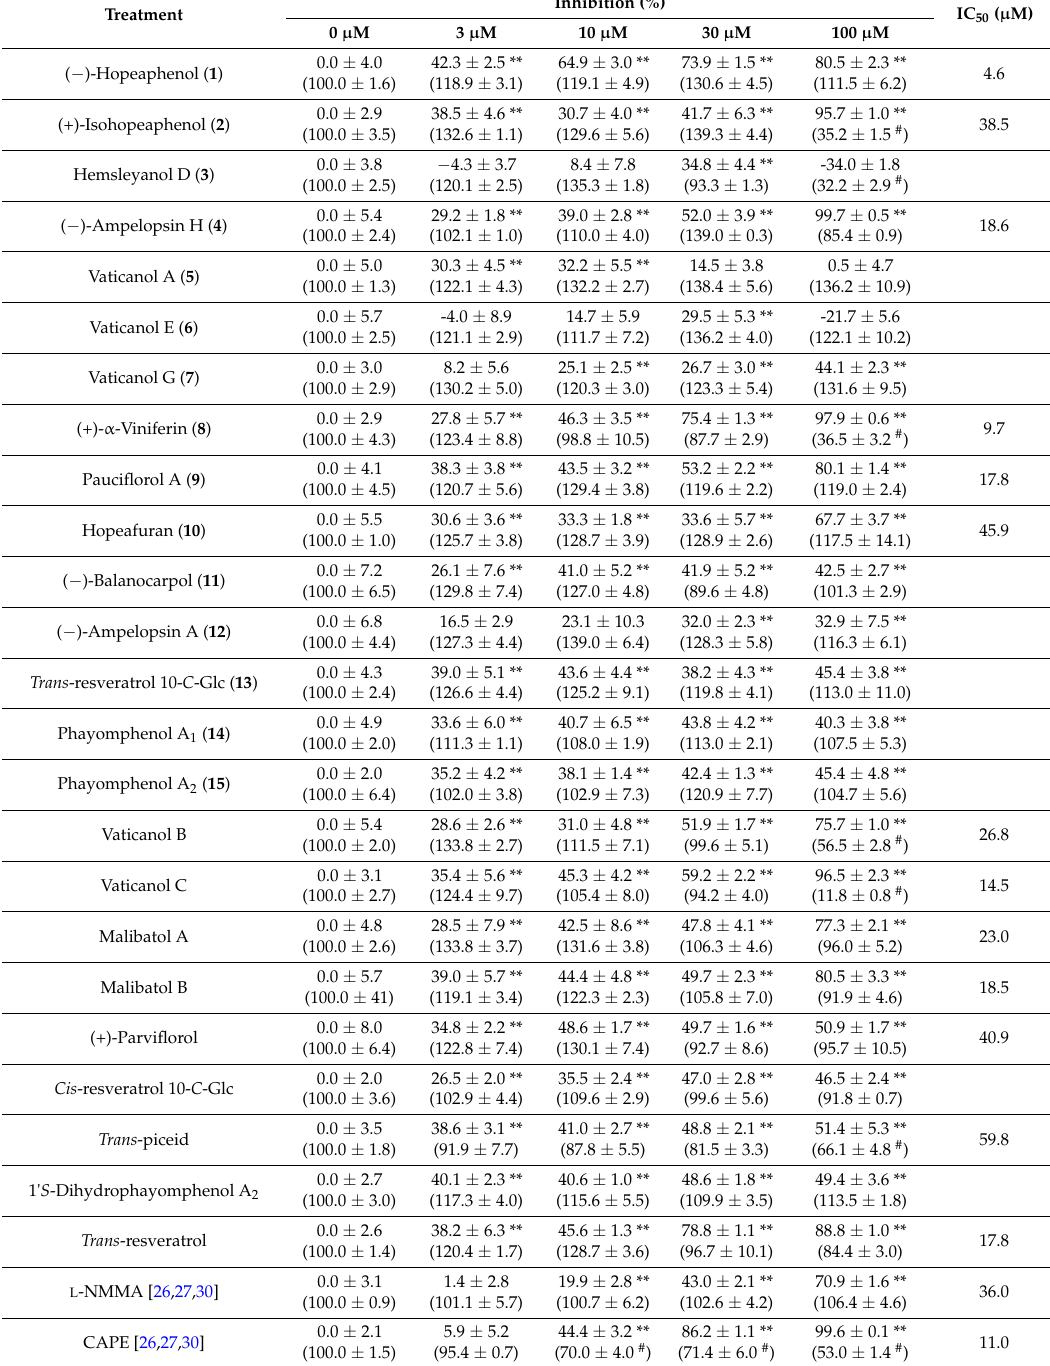
Table 7. Inhibitory effects of the constituents from bark of Shorea roxburghiii on LPS-activated NO production in mouse peritoneal